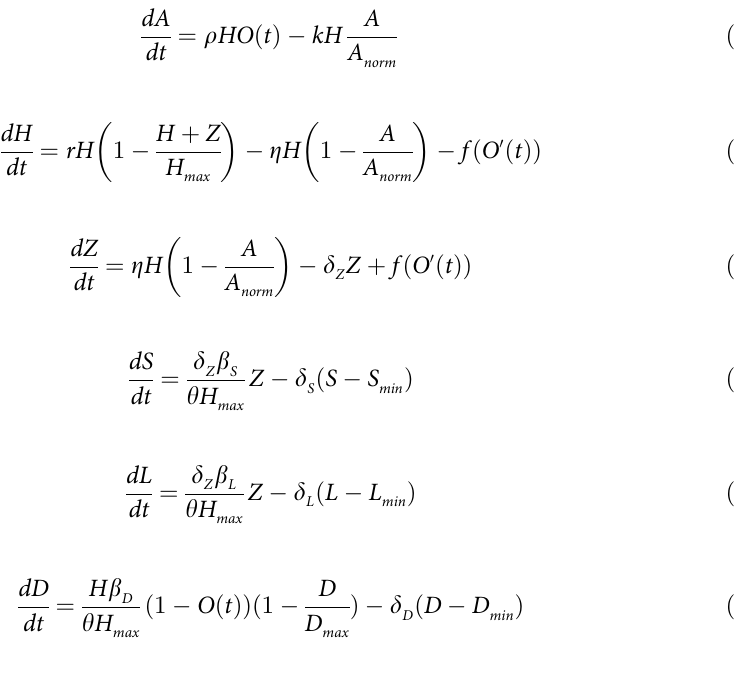
Fig 2. Schematic depiction of the model. Solid arrow indicates conversion of the same variable from one state to another, dotted arrow indicates influence of a variable on the transition rate, and double arrow indicates secretion of biomarkers. See expressions terms of the Model System 1–6 to understand the appropriateness of arrows. The initial conditions used to solve the ODE system are H � = H max , A � = A norm , Z � = 0, S � = S min , L � = L min , D � = D min .